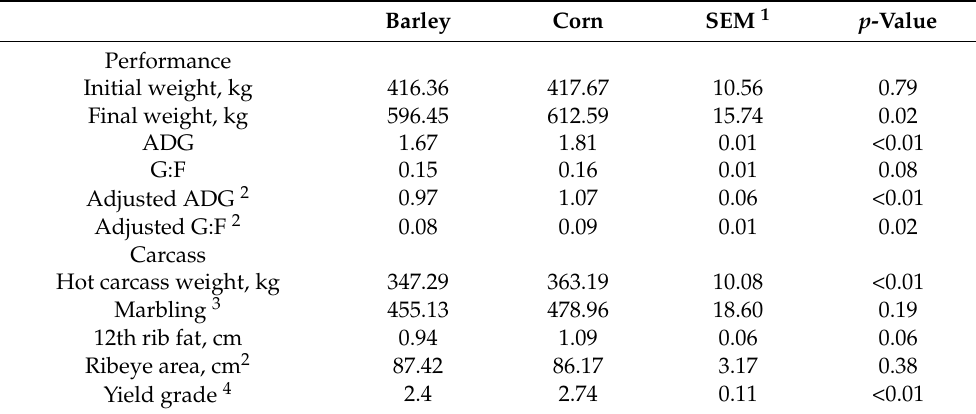
Table 2. Performance and carcass characteristics of steers consuming finishing diets containing corn or Hockett barley as basal grains at the Northern Agricultural Research Center. Barley Corn SEM 1 p